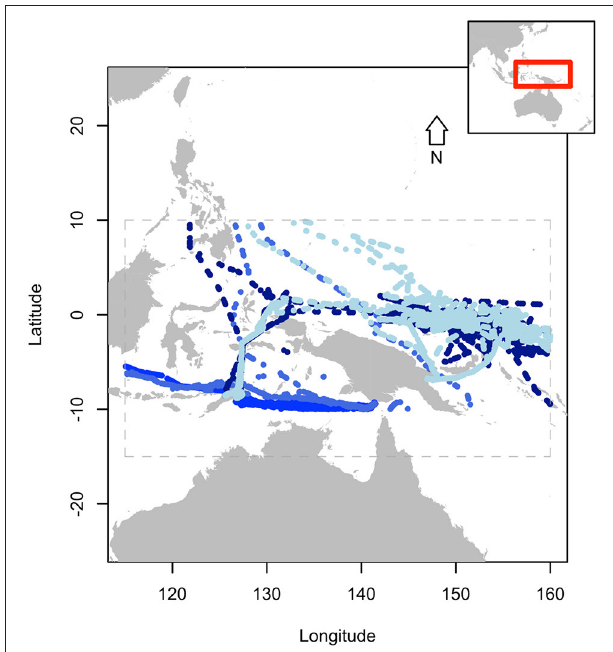
FIGURE 2 | Tracks of four supply vessels noted to have had irregular behaviors. Gray dashed lines indicate extent of data for purposes of presentation. Inset box displays extent of data in larger